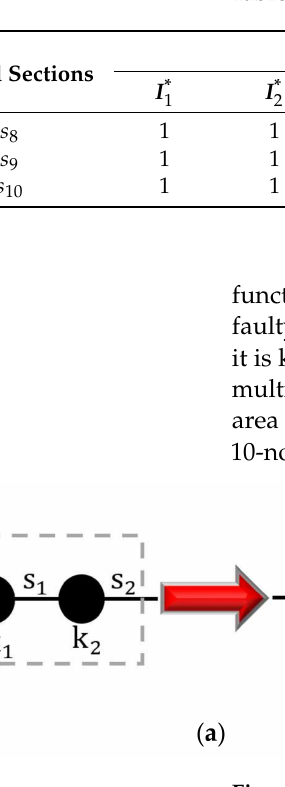
Figure 3. Single-branch equivalent area model. ( a ) Area division schematic; ( b ) Regional division